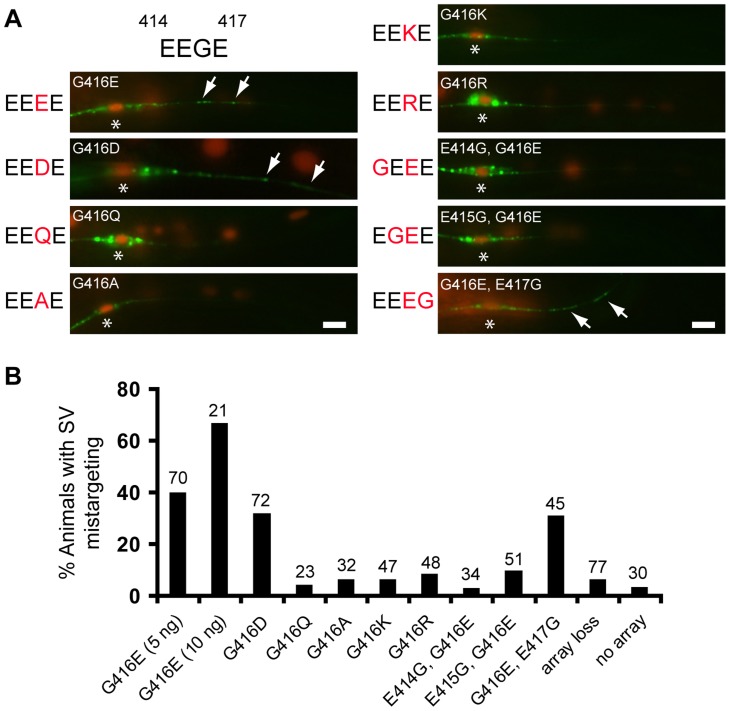
Negative charges of the EEGE cluster in the MEC-12 H12 helix instruct synaptic vesicle targeting.(A) Effects of G416 substitution on SV targeting in the PLM neuron. Expression of respective MEC-12 variants in the mec-12(e1607) was indicated by the cell-autonomous marker Pdpy-30::NLS::dsRed. SVs were labeled by jsIs821(Pmec-7::GFP::RAB-3). Arrows, mistargeted SVs. Asterisks, PLM soma. Scale bar  = 5 µm. (B) Quantification of SV mistargeting in animals expressing MEC-12 variants. Array loss, transgenic animals that lost the MEC-12-expressing array from the PLM. No array, non-transgenic animals. Scale bars  = 5 µm.